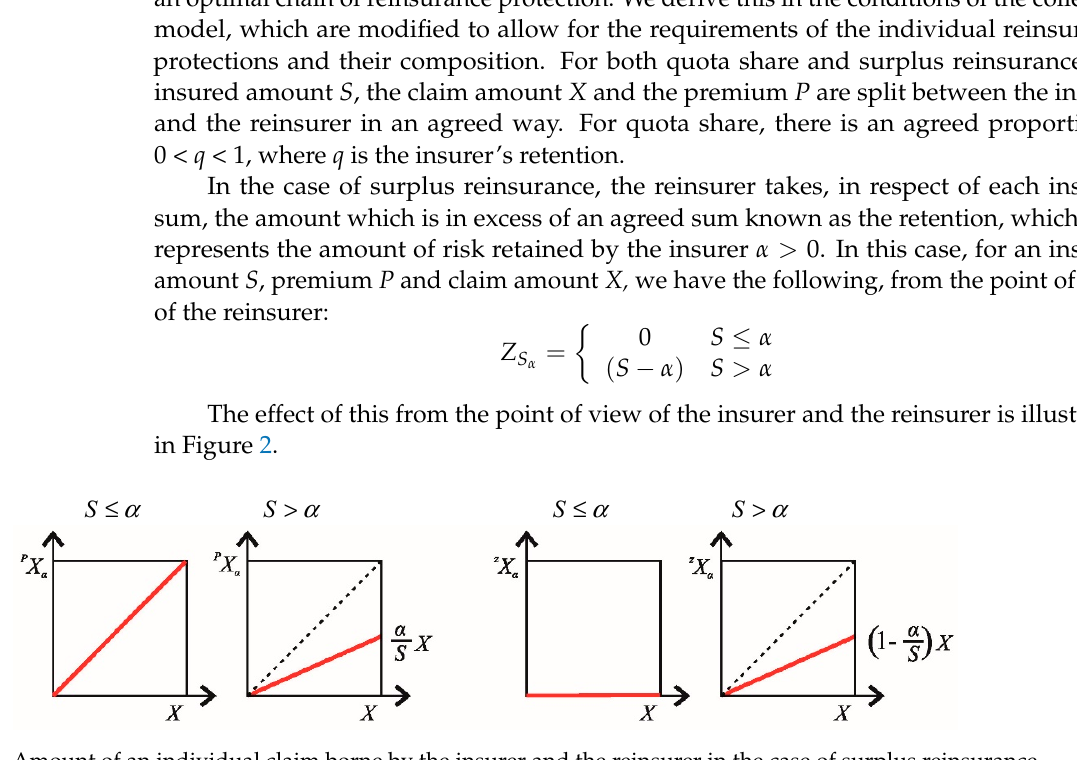
Figure 2. Amount of an individual claim borne by the insurer and the reinsurer in the case of surplus reinsurance.